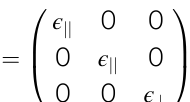
The dielectric function of the TJ ( ϵ regions (Fig. 1b), represented as ϵ TJ ¼ ϵ 0 (cid:2) ϵ Au ω ð Þ (cid:2) ~ ϵ (cid:2) ϵ (cid:2) ϵ Gr hBN d , where ϵ 0 ω ð Þ þ i ϵ 00 ω ð Þ represents the complex dielectric Au Au